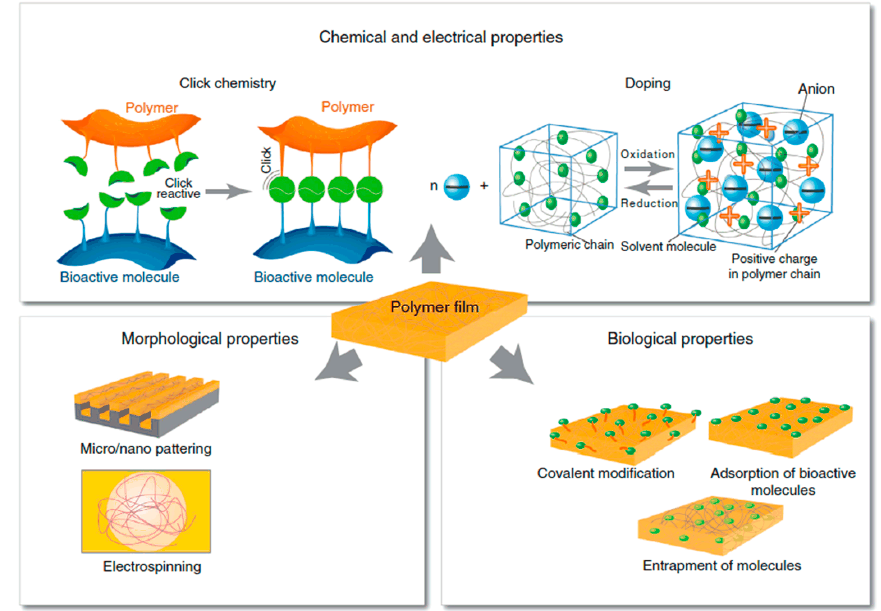
Figure 3. Schematic illustration of characteristics of conducting polymers , reprinted from [33] with permission of Elsevier, Copyright 2013.